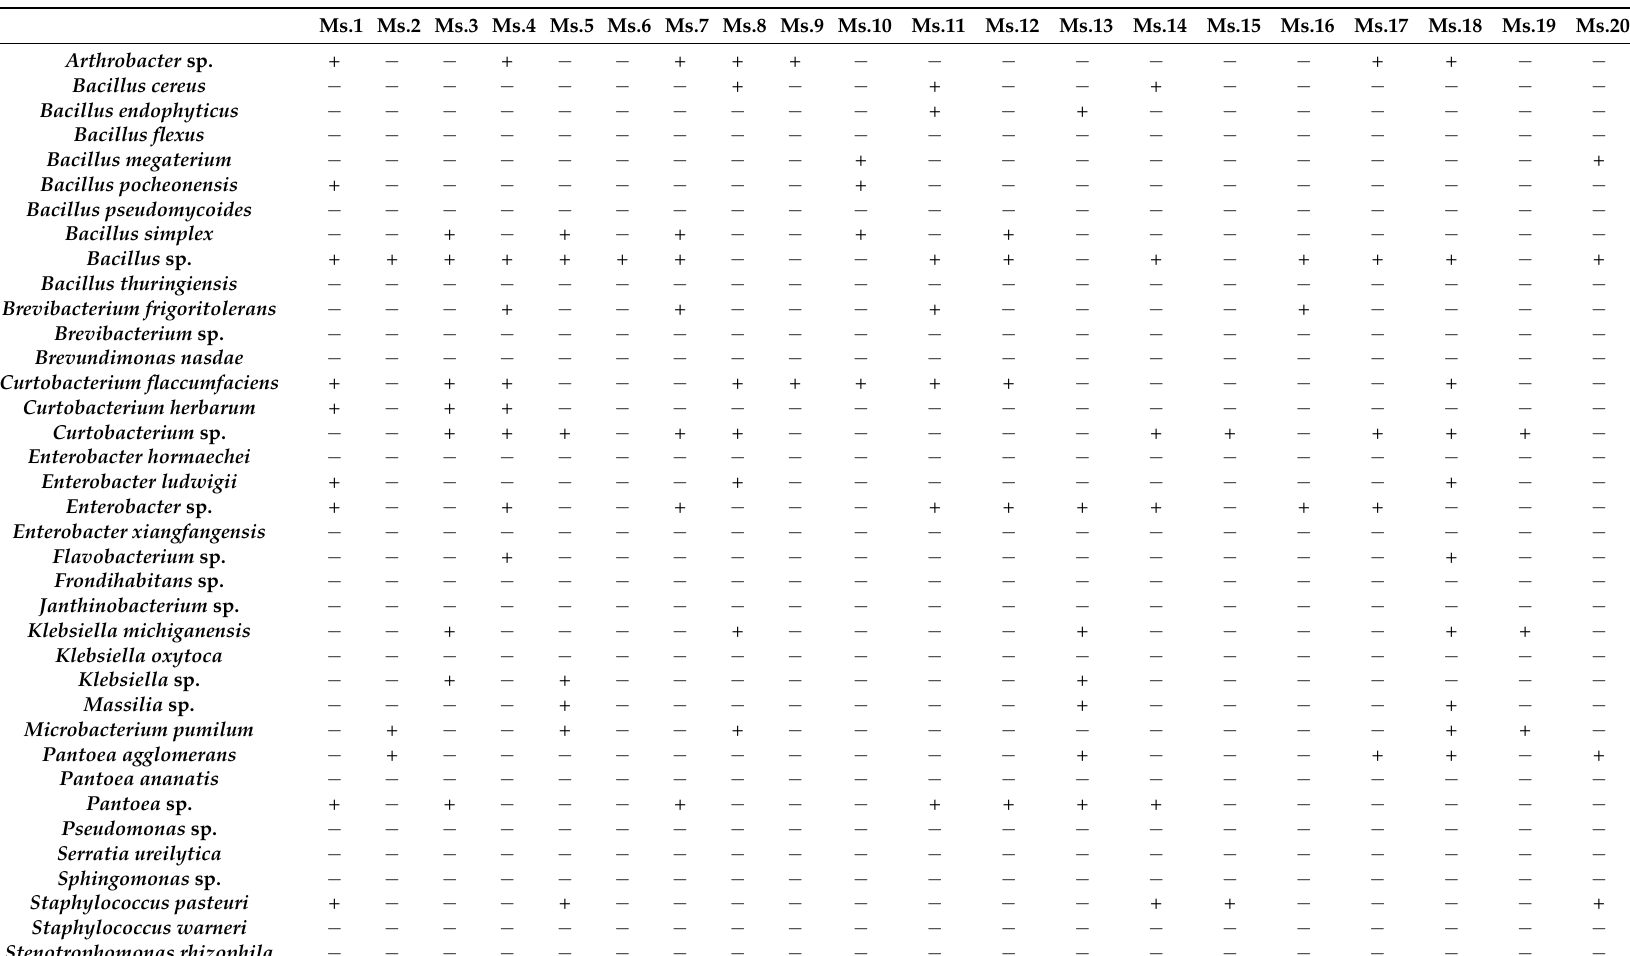
Table 2. Bacterial species isolated from Muscicapa striata